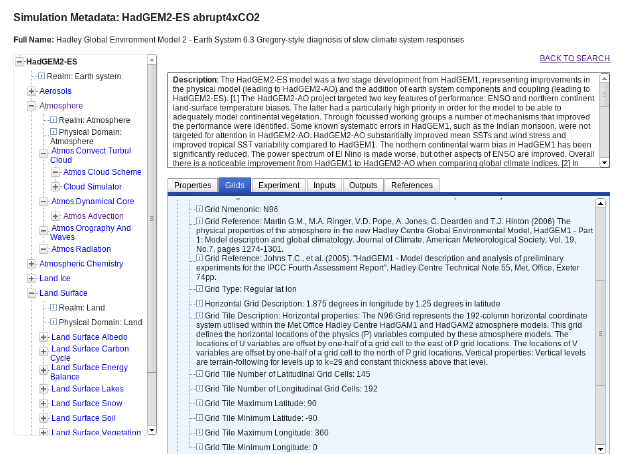
Fig. 3. An example of CIM content rendered by software developed by the US Earth System Curator project integrated into the Earth System Grid Gateway (from http://earthsystemgrid.org, on the 17 April 2012). Elements of Simulation, Software, and Grid documents are shown. The box on the left shows some of the software compo- nent structure in a “tree-control”. The title and abstract are those of the Simulation, and the Grid tab exposed is showing part of one of the grids used. A user can navigate around this representation of the CIM content to find out details of component properties, inputs and outputs etc.